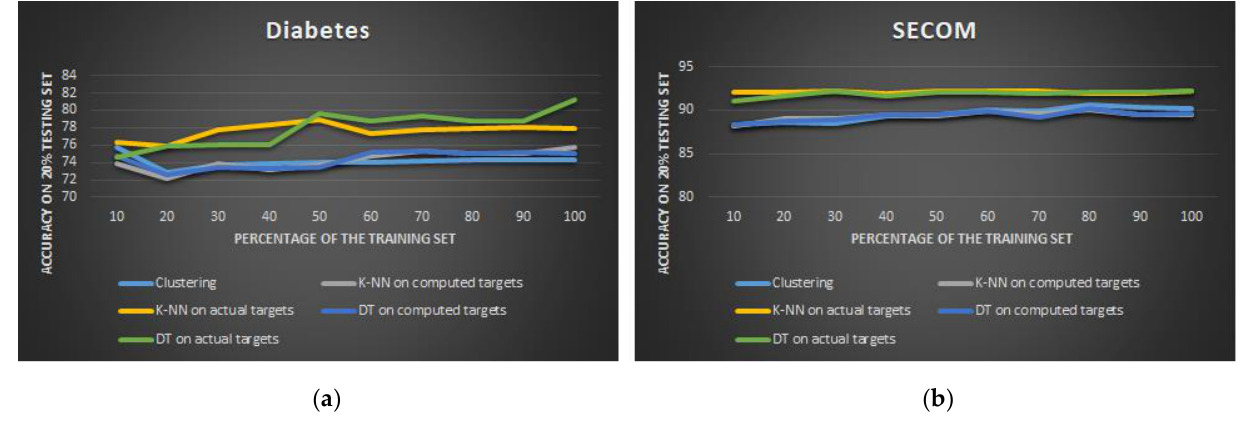
Figure 3. Learning curves on ( a ) diabetes and ( b ) SECOM datasets.